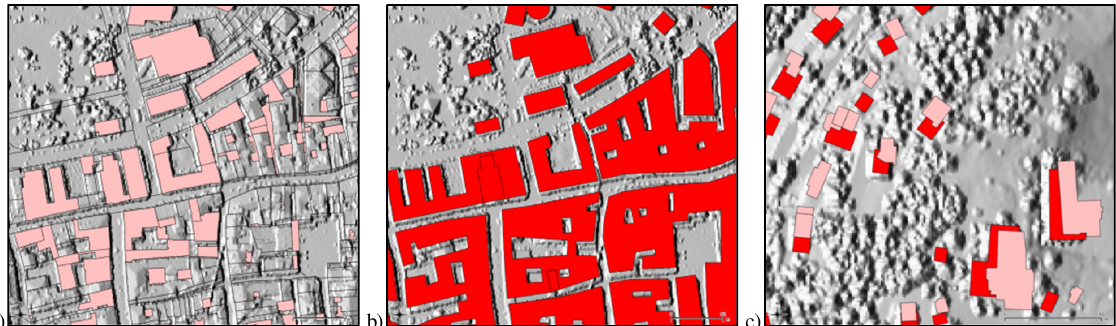
Figure 2: Evidence of issues with the vector maps of building footprints in the cadastral (a) and topographic (b) layers. The level of detail is higher in the former, but building footprints are not always correctly identified. The topographic layer is more complete but the buildings are grouped. Distortions and misalignments are particularly evident by overlapping the two layers (c). The topographic dataset was digitised by three different companies starting from two distinct photogrammetric aerial surveys in 1998 and 2004, thus presents some mosaicking problems. Topographic footprints and DSM overlay correctly, are complete and up-to-date, with proper accompanying attribute.